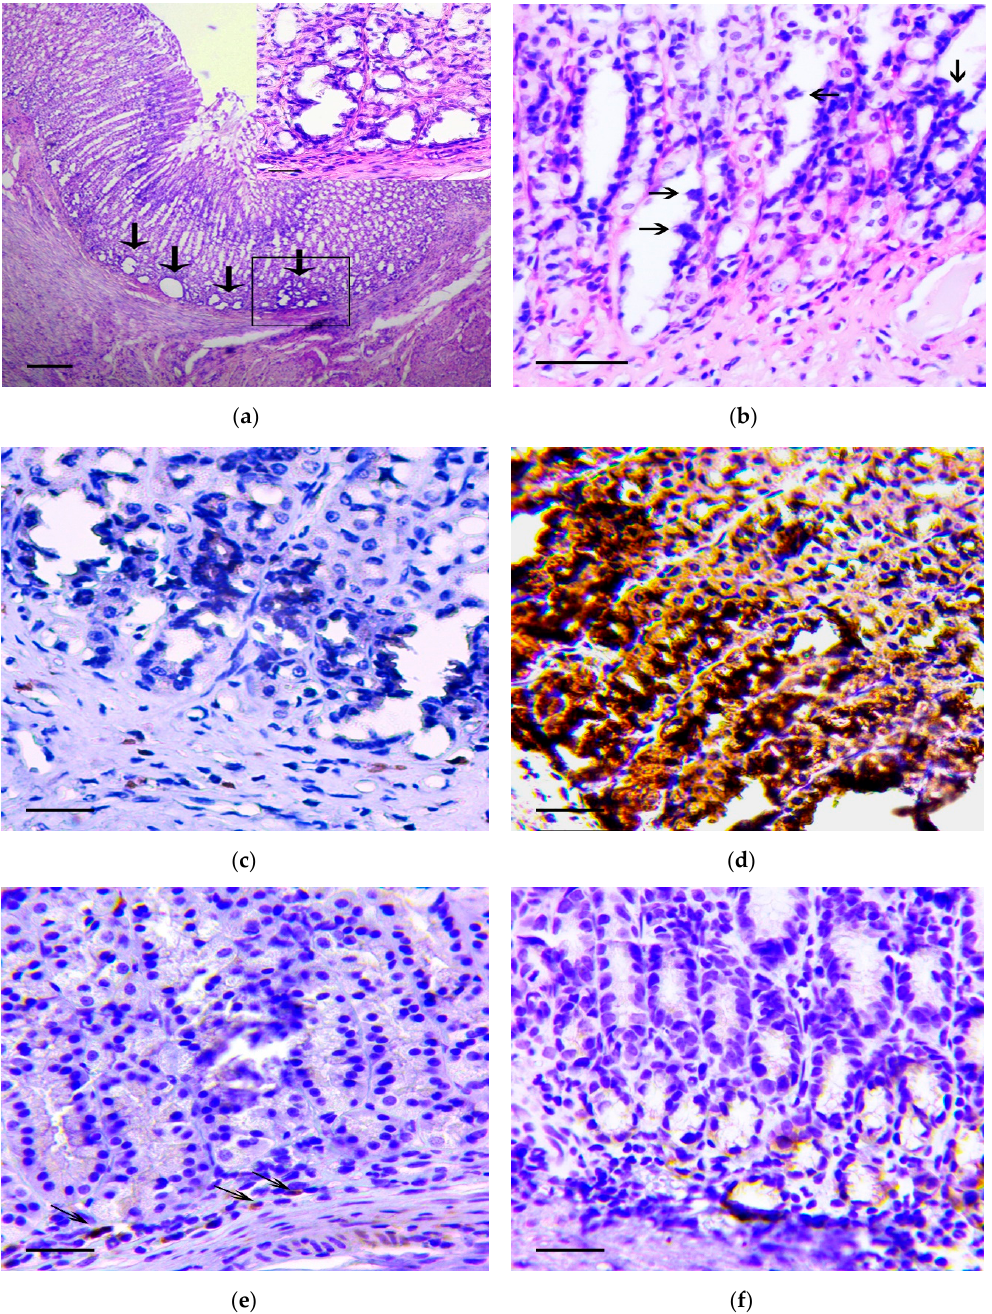
Figure 2. The pathological changes in stomach body. ( a ) Basal part of gastric glands with marked cytological and architectural atypia (arrows). In the box the selected area is shown. H&E staining, scale bar 200 µm (in box—100 µm). ( b ) Proliferations of atypical epithelium in the lumen of glandular-like structures (arrows). H&E staining, scale bar 100 µm. ( c – d ) The marked Snail ( c ) and TGF- β 2 ( d )